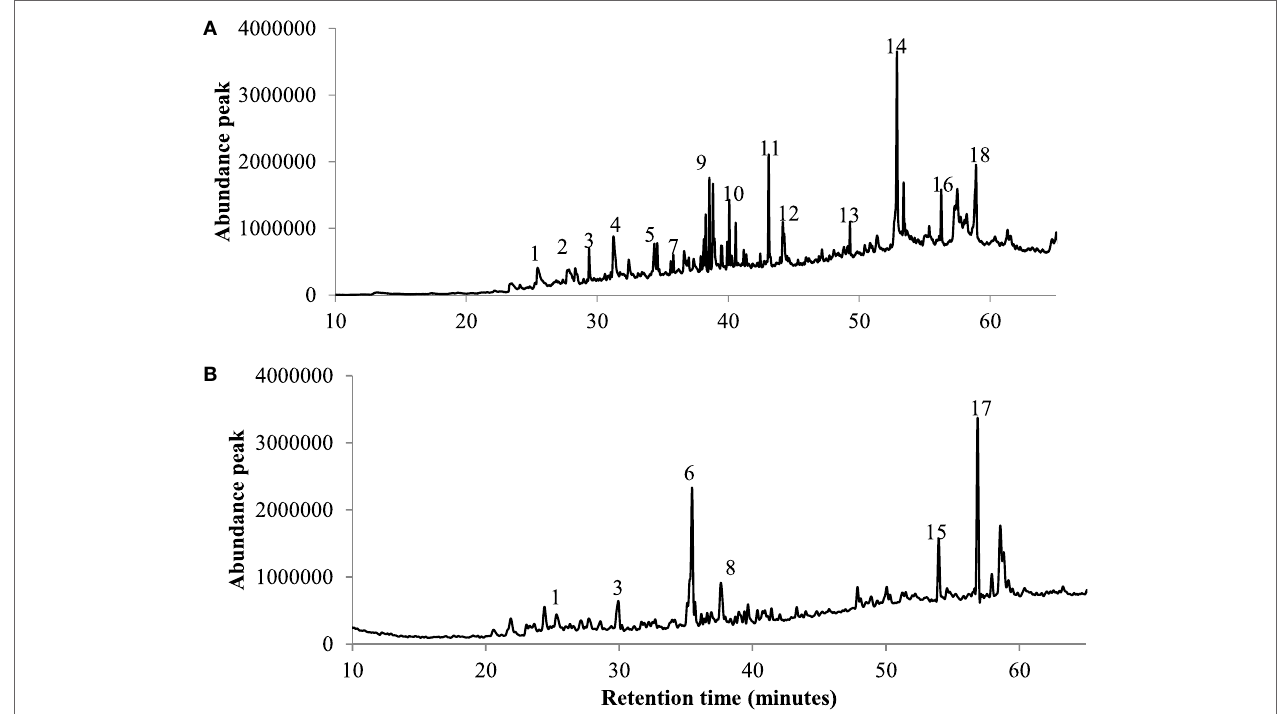
FigUre 4 | gc–Ms chromatogram of the bio-crude oils at 350°c processing Chlorella , where (a) shows the non-catalytic run and (B) shows the MoZsM-5 . (1) 25.4 min 4-methyl-phenol; (2) 27.8 min 3-ethyl-phenol; (3) 29.4 min hexadecane; (4) 31.7 min 1-butyl-2-pyrrohdinone; (5) 34.3 min 3-methyl-indole; (6) 35.4 min 3-octadecene; (7) 36.6 min benzonitrile; (8) 37.6 min 2,3-dihydro-1-methyl-1 H -pyrrole; (9) 38.3 min 3,7,1 l,15-tetramethyl-2-hexadecene; (10) 40.5 min 7-hexadecyn-1-ol; (11) 43.1 min isophytol; (12) 44.1 min ethyl-phenyl-piperidine; (13) 49.1 min 1-nonadecene; (14) 52.8 min hexadecademide; (15) 53.8 min 9-octadecenamide; (16) 53.6 min (5-amino-thiadiazol-2-yl)-propyl-3 H -benzooxazol-2-one; (17) 56.3 min 2-butylhexanoic acid, 3-pentyloxycarbonylpropyl ester; (18) 58.8 min octanoic acid,